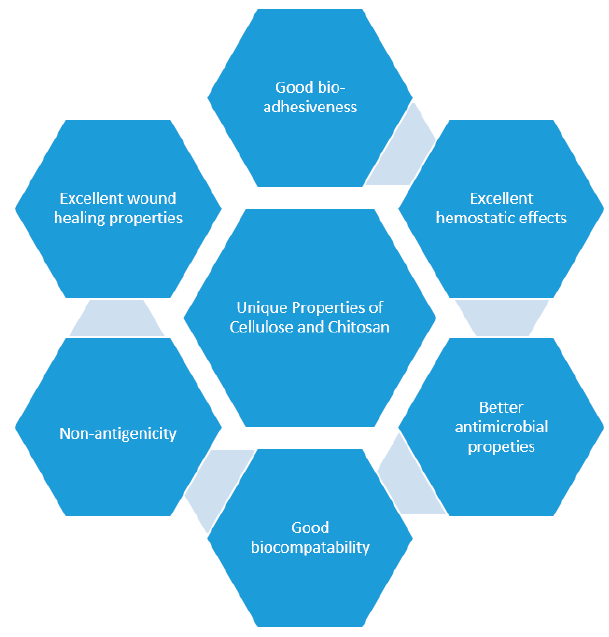
Figure 1. Properties of chitosan and cellulose.